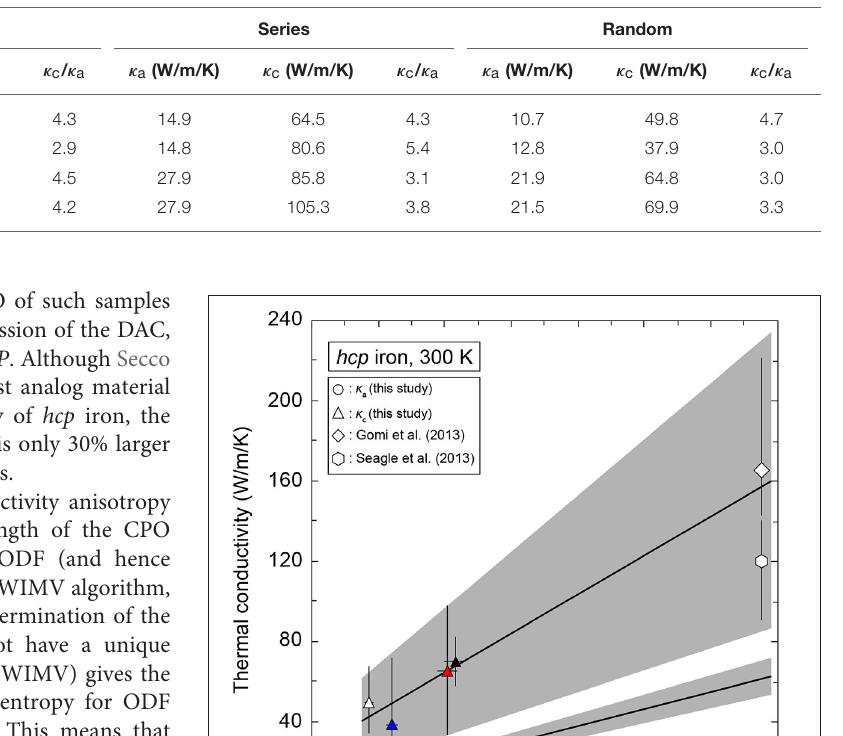
that are 0.43 and 0.98 W/m/K/GPa, respectively, we estimated κ a and κ c of hcp iron at higher P , indicating the anisotropy in the conductivity is maintained to the core pressures ( Figure 12